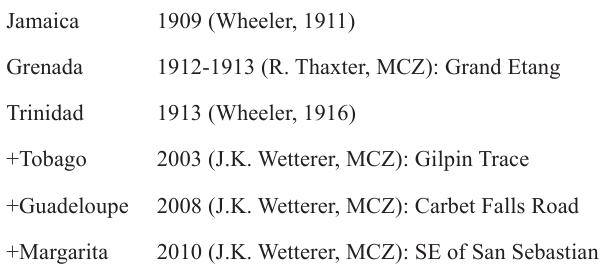
Table 2 . Earliest known records for Pachycondyla harpax on West Indian